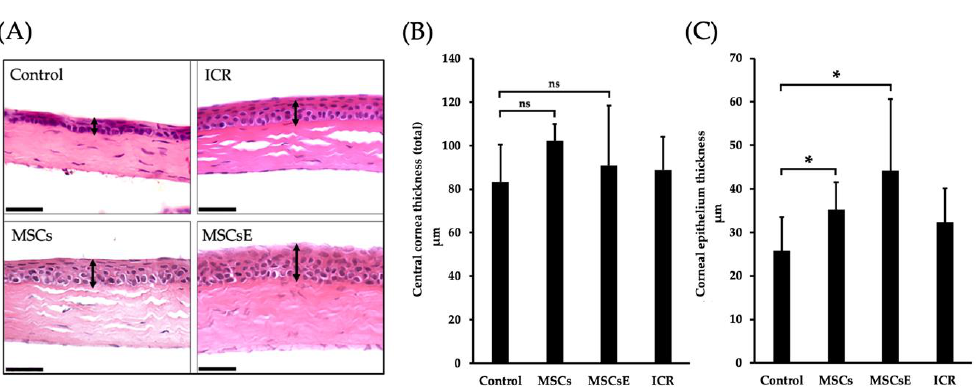
Figure 4. Thickness of the central cornea (total) and the corneal epithelium at 16 weeks